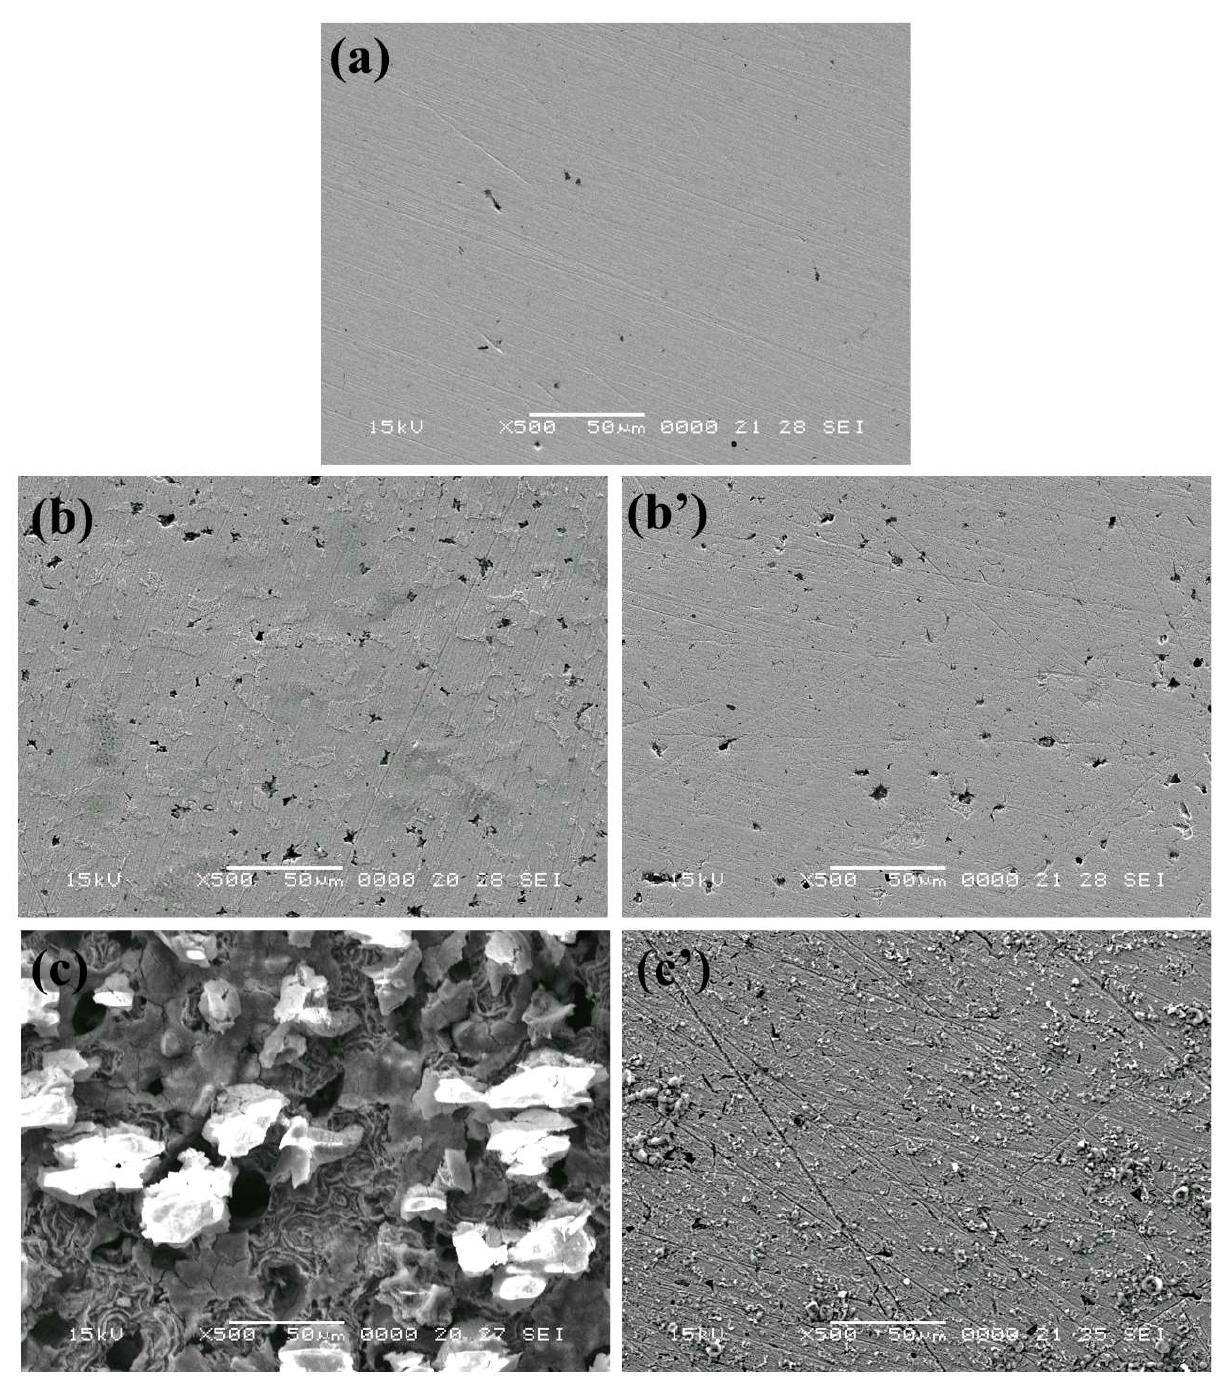
Figure 8. SEM images of C-steel surface before ( a ) and after 1 h ( b , b’ ) and 12 h ( c , c’ ) of immersion in 1.0 M HCl solution in the absence ( b , c ) and in the presence of 5 mM PyODT ( b’ , c’ ).